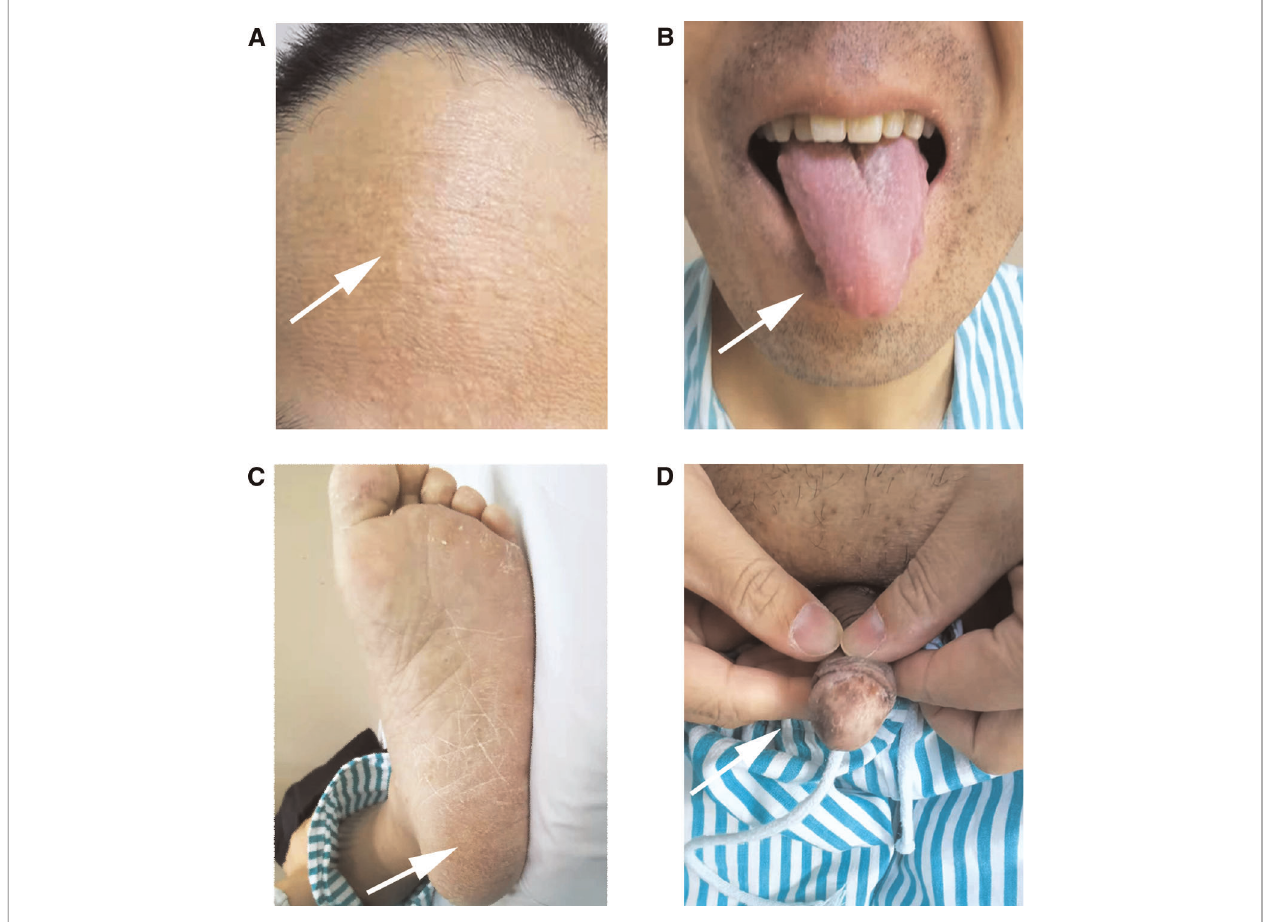
FIGURE 3 | ( A ) Miliary papules were scattered on the forehead and face, ( B ) papilloma can be seen on the tongue, ( C ) some excessive keratinization can be seen on the soles of the foot, ( D ) melaniosis spots were on the glans of the